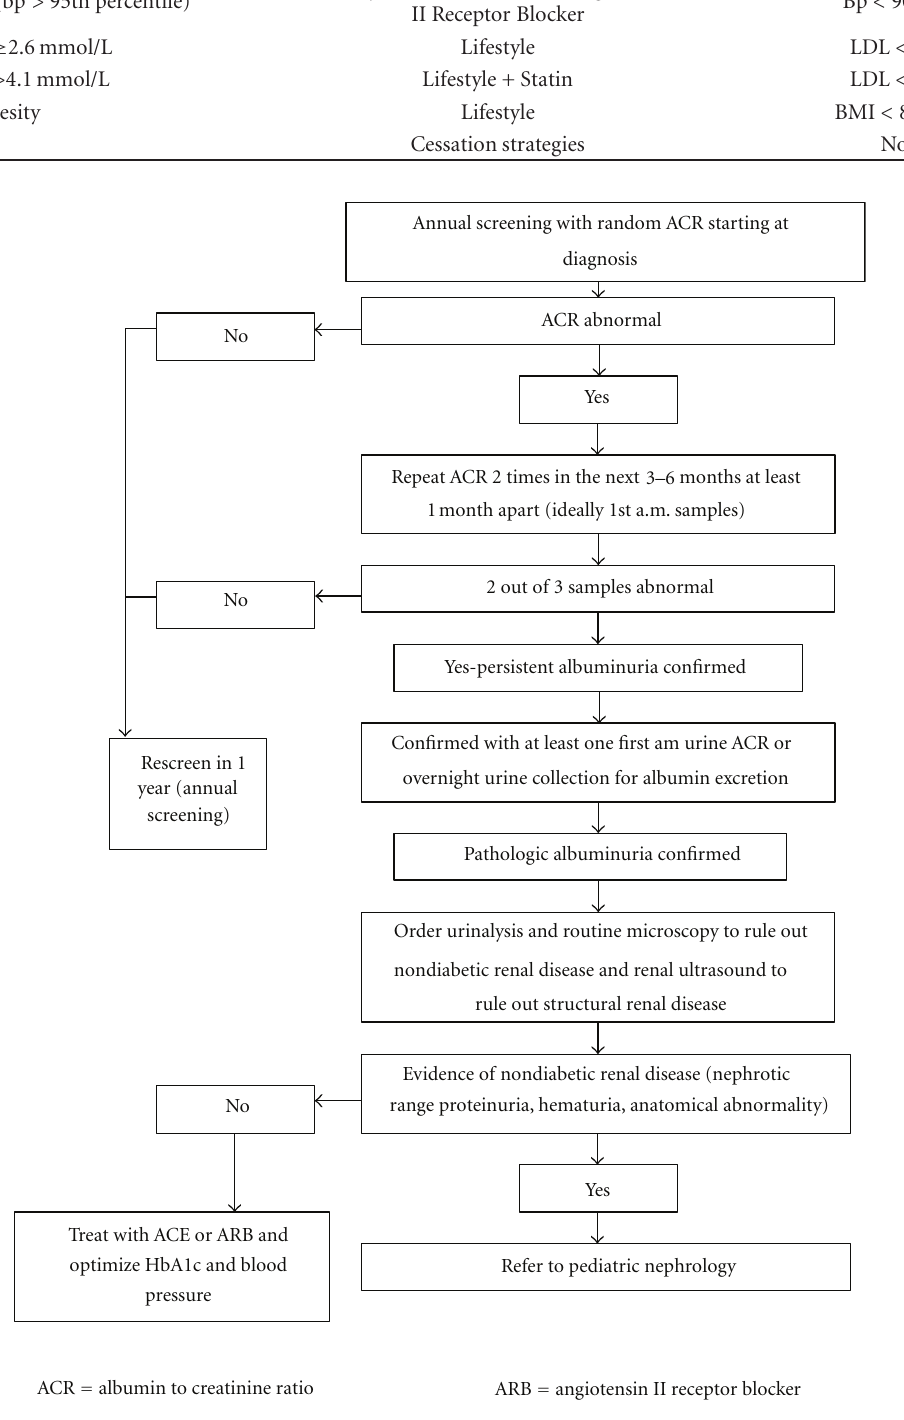
Figure 1: Screening algorithm for albuminuria in youth with type 2 diabetes (modified from CDA guidelines)